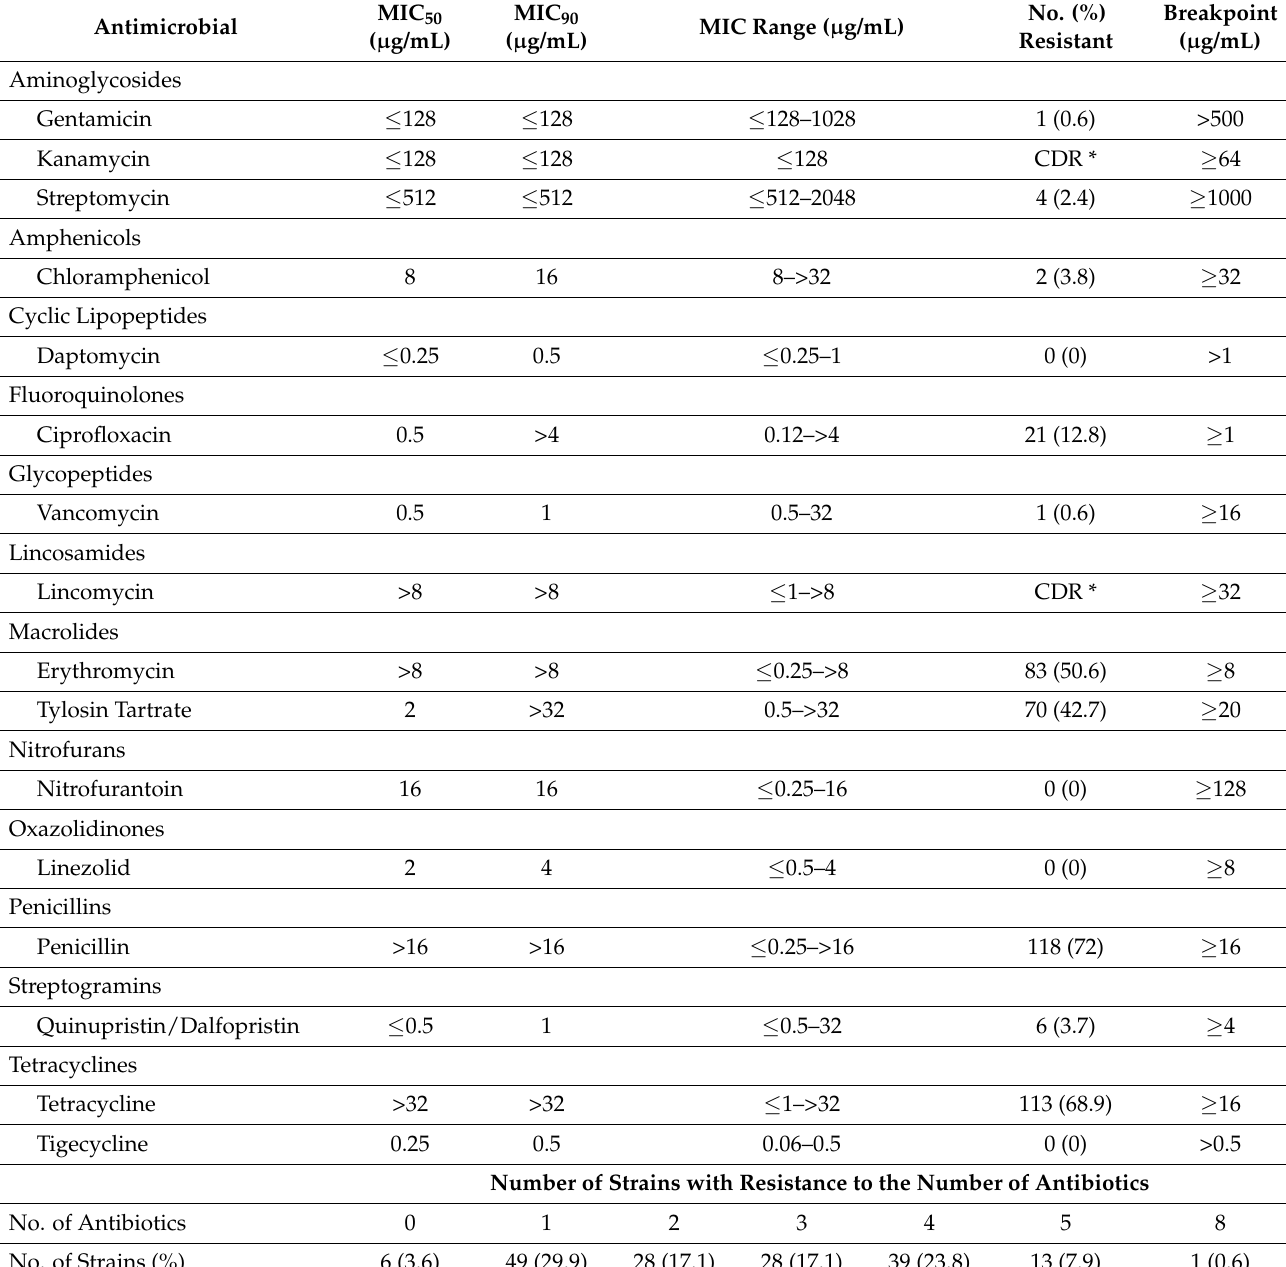
Table 1. Antimicrobial resistance profiles among 164 Staphylococcus aureus strains isolated from swine feces, swine mandibu- lar lymph node tissue, and commercial pork sausage meat. MIC = minimum inhibition concentration.